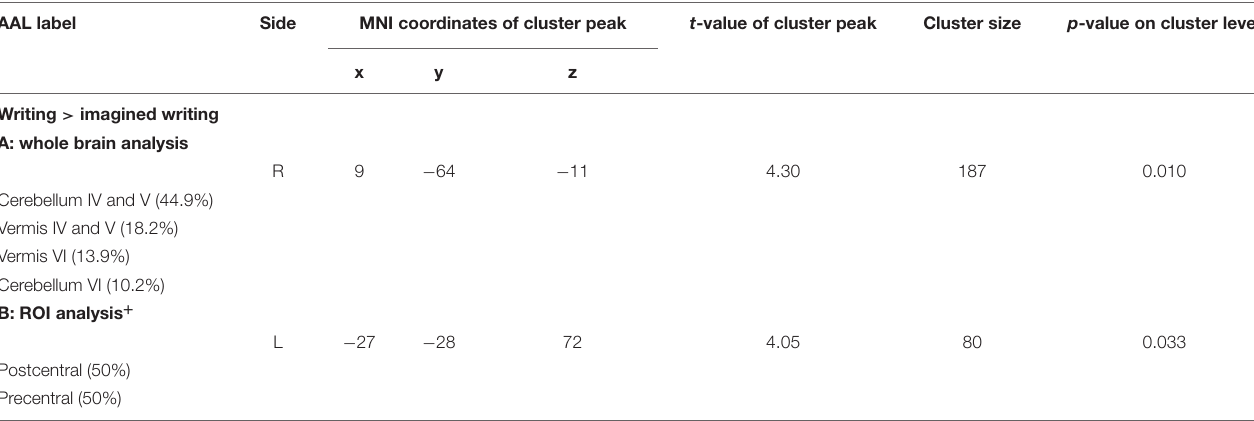
FIGURE 4 | T-maps of BOLD differences in the contrast writing > imagined writing. The contours (referring to the AAL atlas) depict the cluster’s participating regions: (A) writing activated parts of the ipsilateral cerebellum (Lobule IV and V, blue contour; Lobule VI, light green contour; Vermis IV and V, dark green contour; Vermis VI, orange contour) more than the imaged writing. (B) Parts of the precentral (blue contour) and postcentral (red contour) gyrus showed a stronger BOLD response on writing compared to imagined writing. Clusters are significant within the ROI analysis after FWE-correction on p < 0.05. CER, cerebellum; M1, primary motor cortex; S1, primary somatosensory cortex; VER, vermis. TABLE 3 | Results of the second level contrast writing > imagined